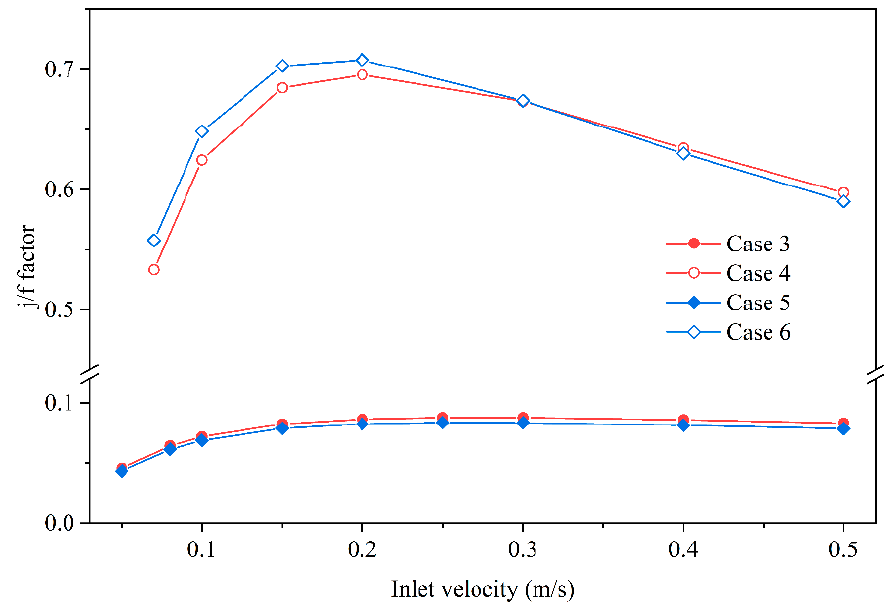
Figure 11. Variations of the j/f factor with the inlet velocity change for Cases 3–6.